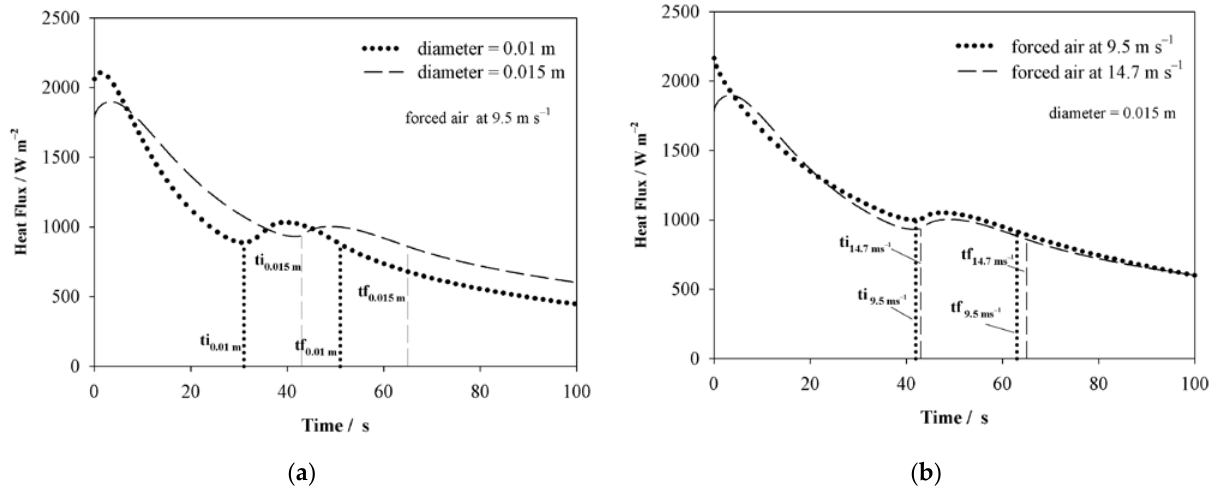
Figure 3. Heat flux estimated by solving the inverse heat conduction problem as a function of ( a ) diameter and ( b ) air